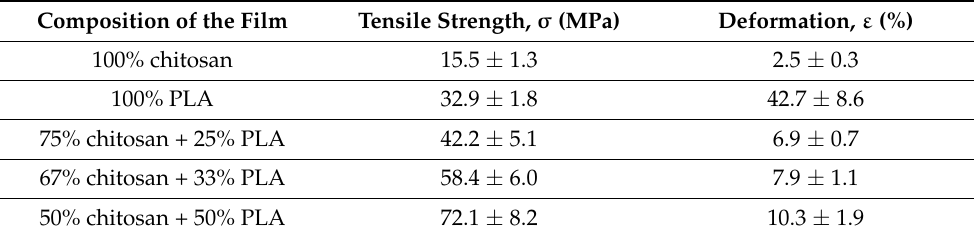
Table 4. Physical and mechanical characteristics of samples. Composition of the Film Tensile Strength, σ